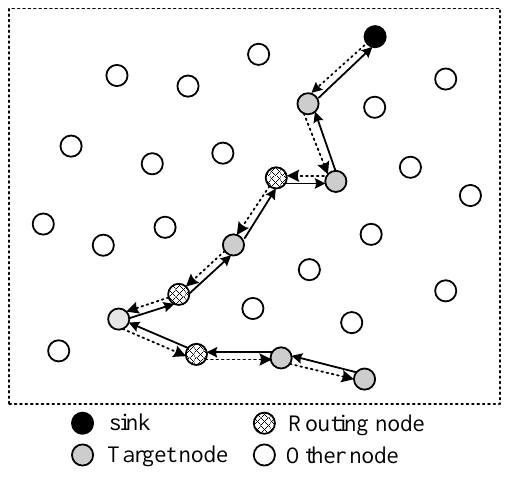
Figure 3. Linear structure.